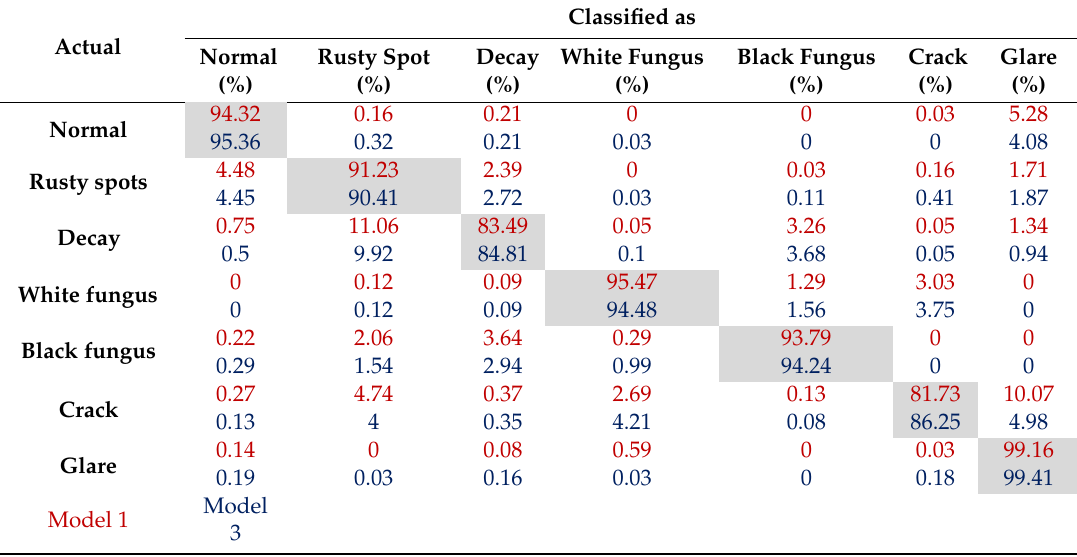
Table 2. Confusion matrices of the classification models with the use of linear scan